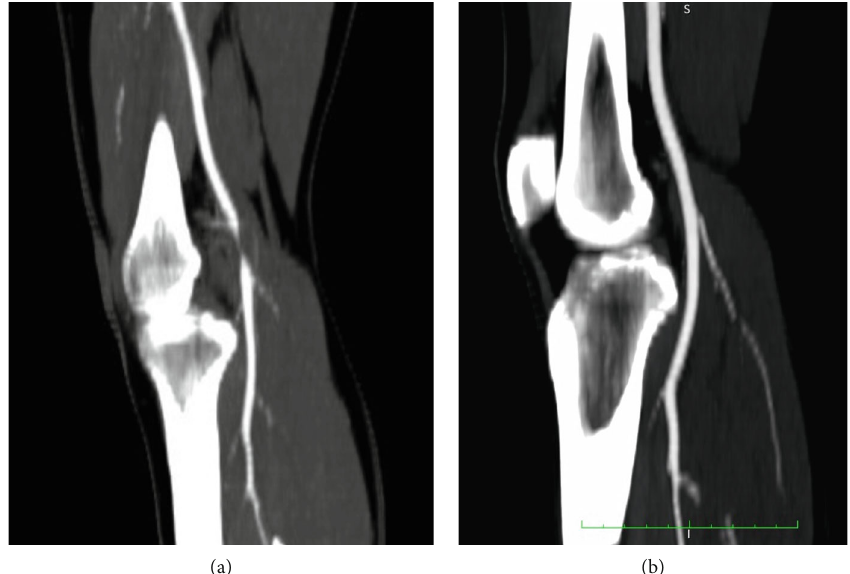
Figure 2: Saggital cut of the CT angiography at the level of the knee: (a) at time of presentation with the arrow showing an obstruction in the right popliteal artery and (b) done at 6 months postpresentation, with no sign of